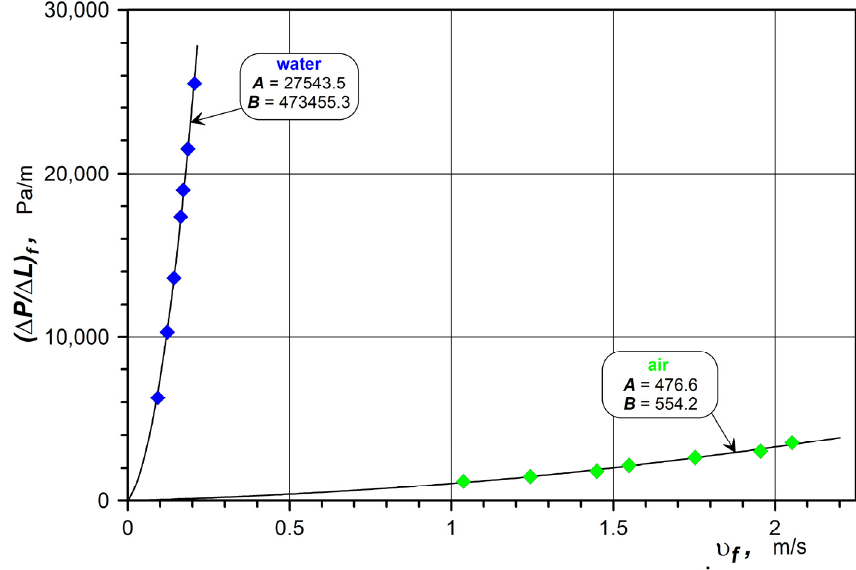
Figure 8. Results of measurements of foam permeability applied in this research. Table 3. Constants and exponents in Equations (18) and